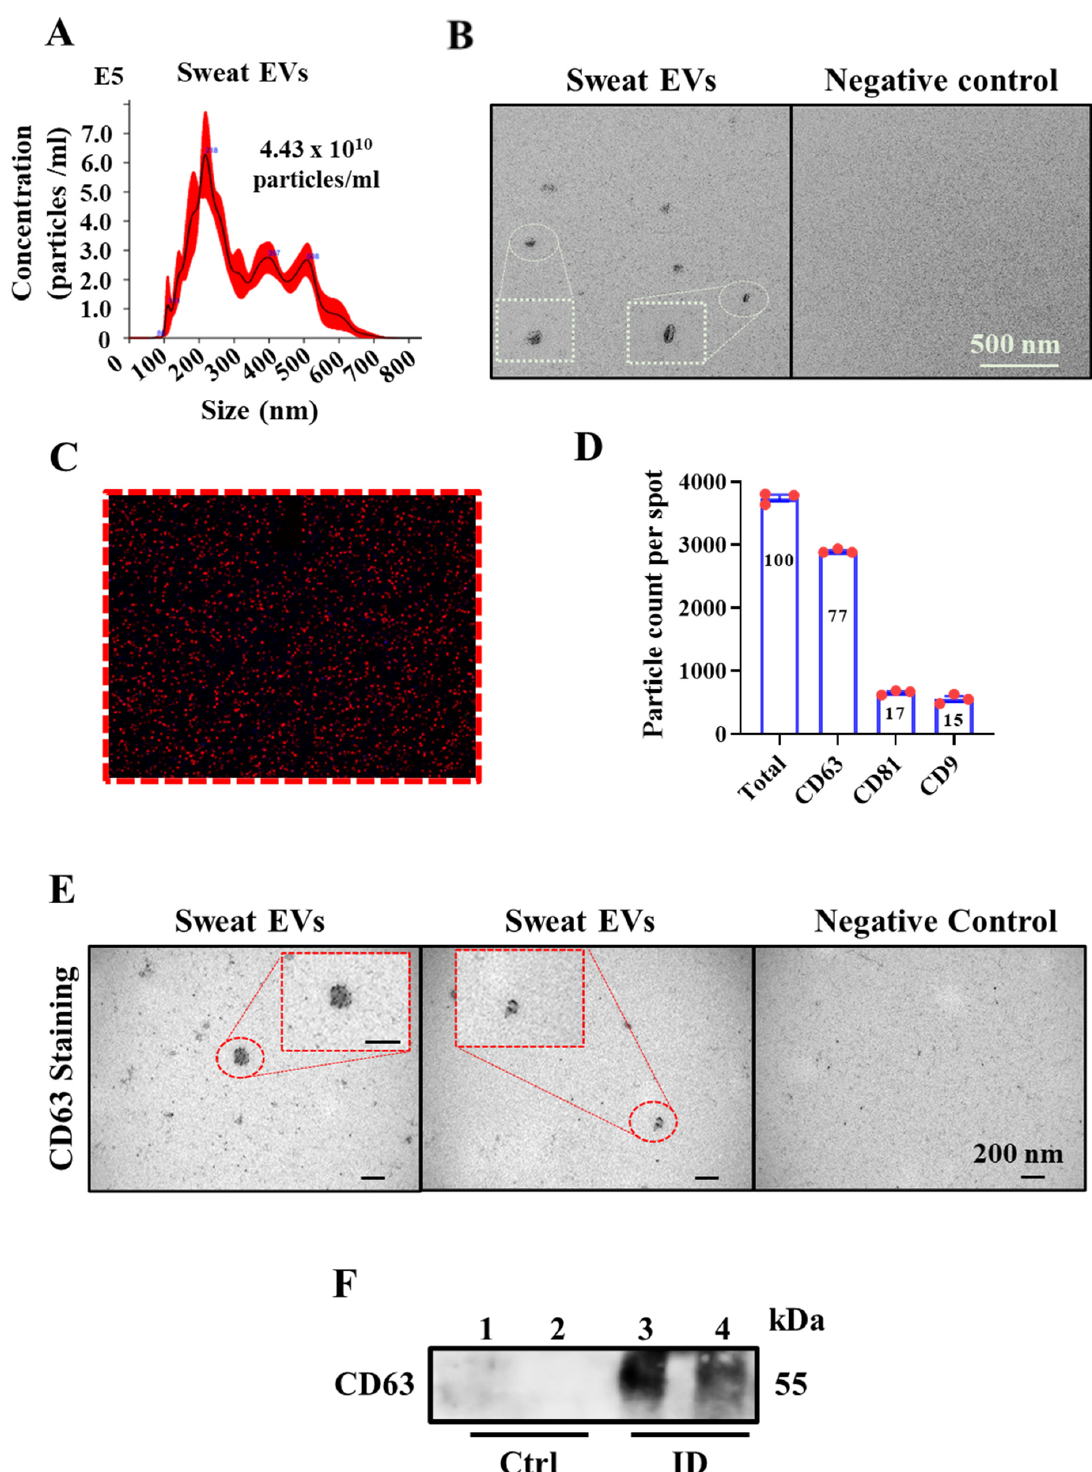
Figure 2. Characterization of sweat EVs. ( A ) NTA analysis of sweat EVs isolated from healthy control participants. ( B ) Electron microscopy analysis. Negative staining of sweat EVs isolated from patches; control refers to the negative patch (was not attached to the patient, but processed in the same way as the positive patches). Scale bar = 200 nm. ( C , D ) ExoView analysis of sweat EVs. ExoView image of sweat EVs, stained with antibodies against CD63 (red), CD81 (green), and CD8 (blue), was captured using ExoView R100 reader. ( C ) Particle counts of sweat EVs indicating the percentage of sweat EVs that express CD63, CD81, and CD9. ( D , E ) Electron microscopy analysis. Immunostaining of